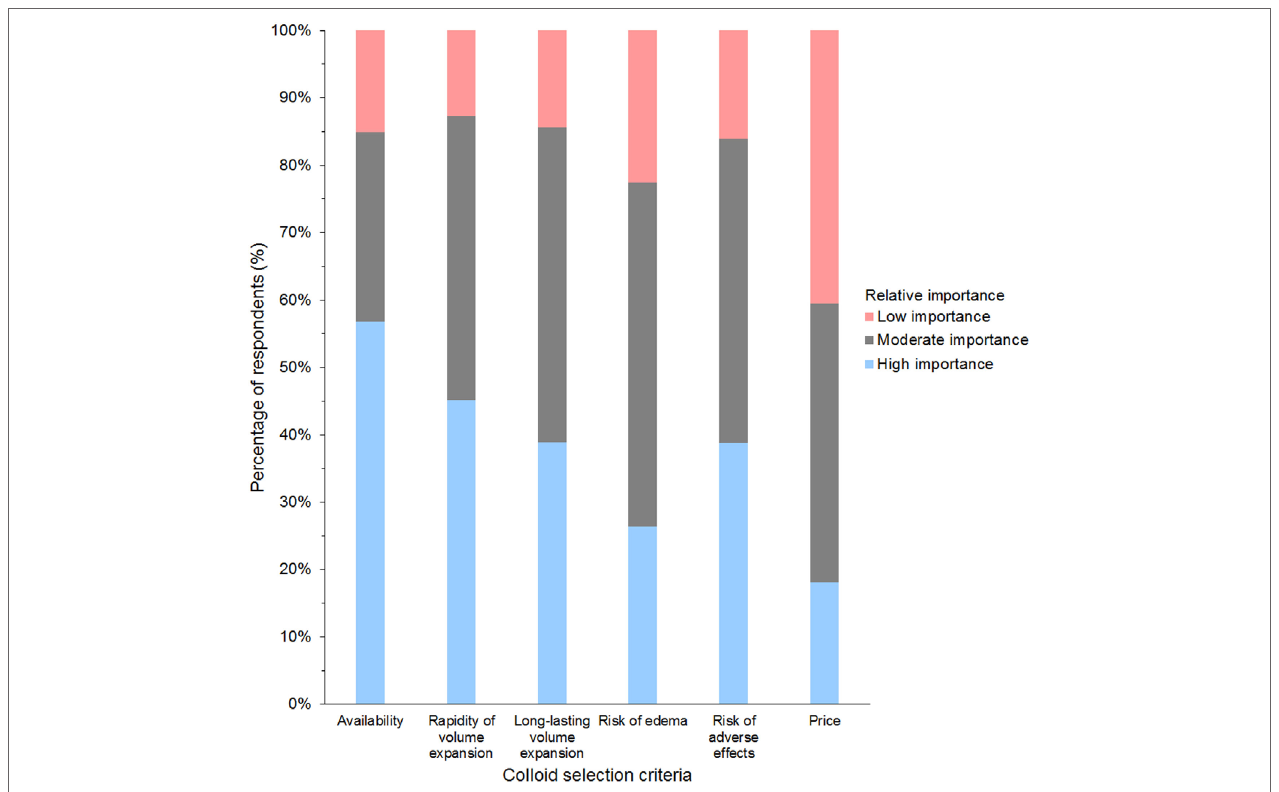
FigUre 8 | Frequency chart showing the relative importance of criteria reported as considerations in the selection of synthetic colloids by 1,024 survey TaBle 1 | Bolus dose of synthetic colloids used for fluid resuscitation by survey respondents. ml/kg